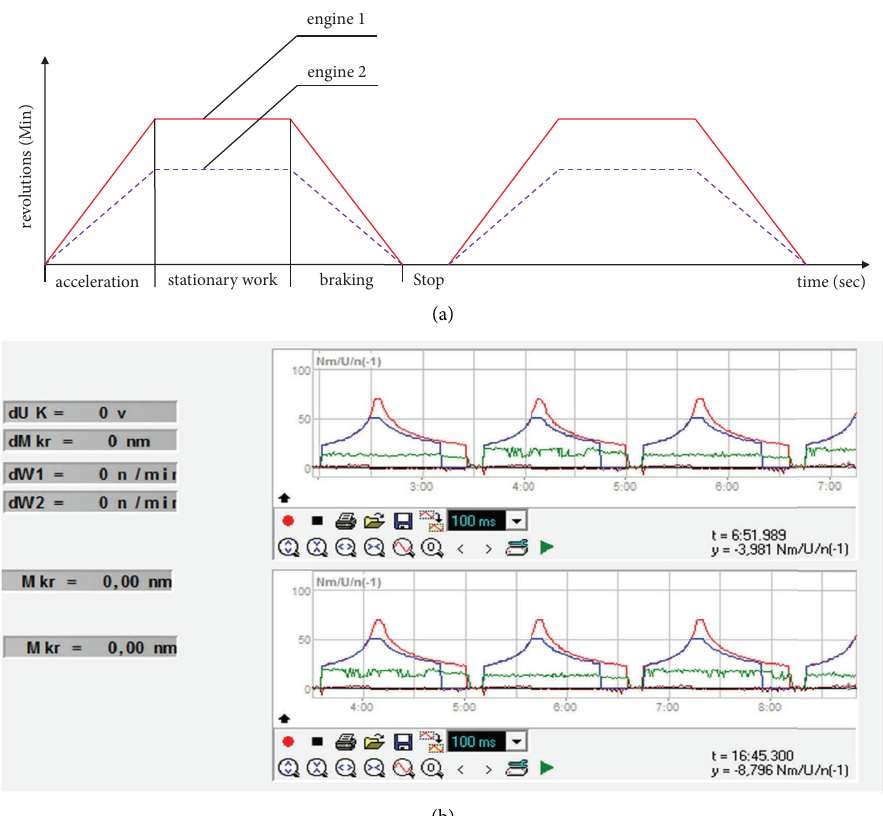
Figure 3: Te scheme of the engines’ operation of the friction installation (a) and the interface of the data processing (b) during the operation of the tribosystem in nonstationary